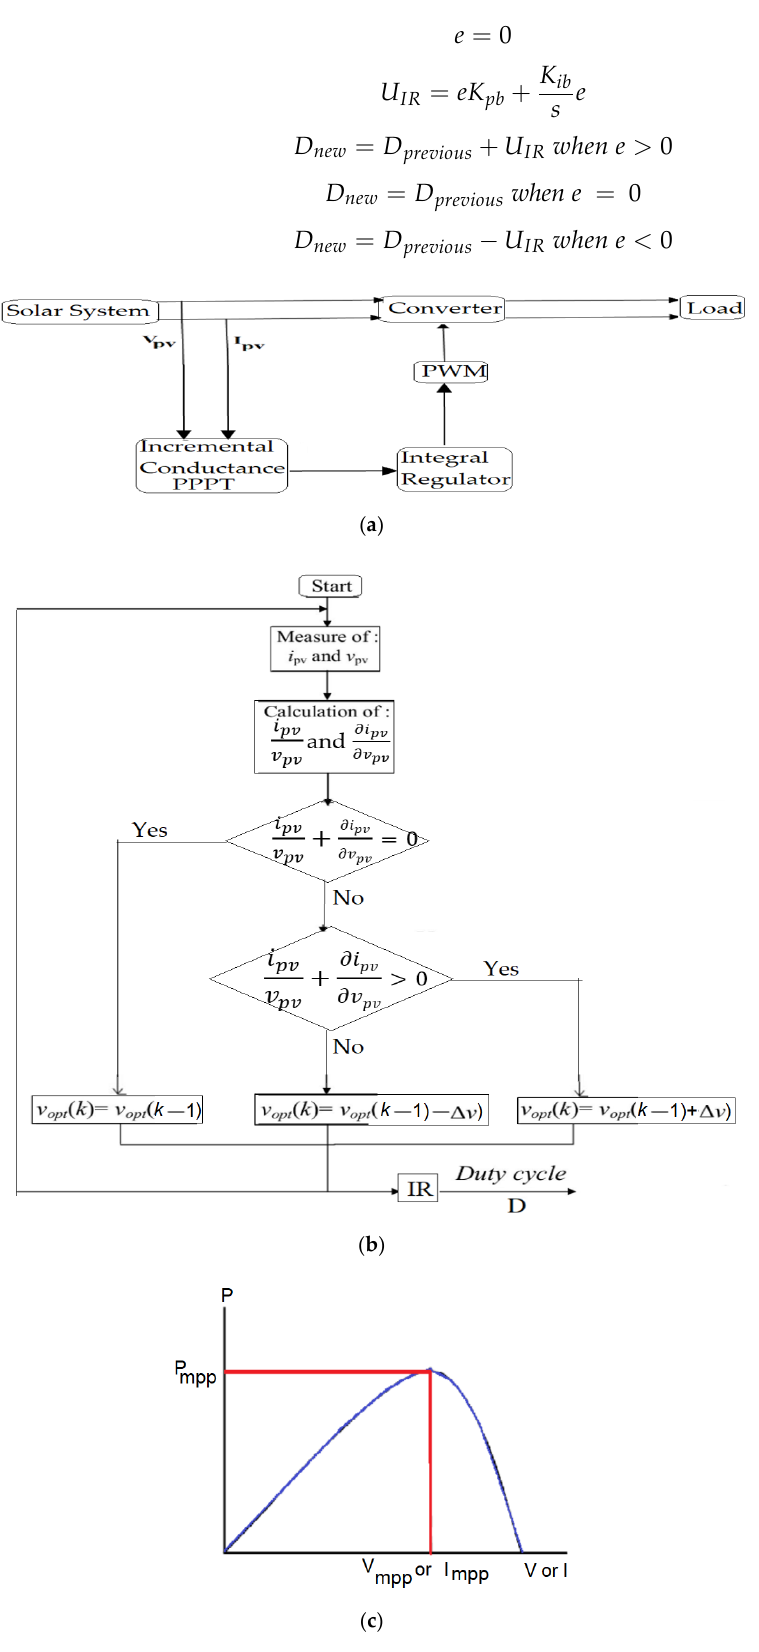
Figure 4. ( a ) Block diagram of incremental conductance with an integral regulator; ( b ) IC PPPT technique flowchart; ( c ) PV array power curve.